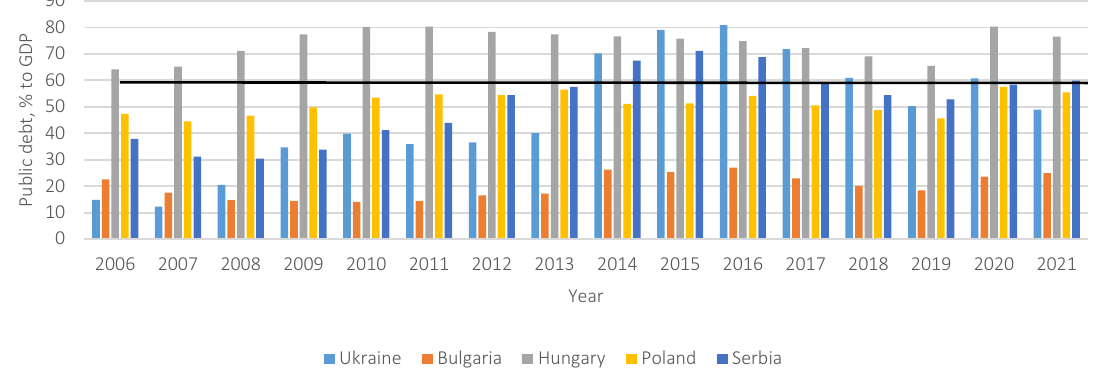
Figure 3. Public debt in % to GDP for Ukraine, Bulgaria, Hungary,